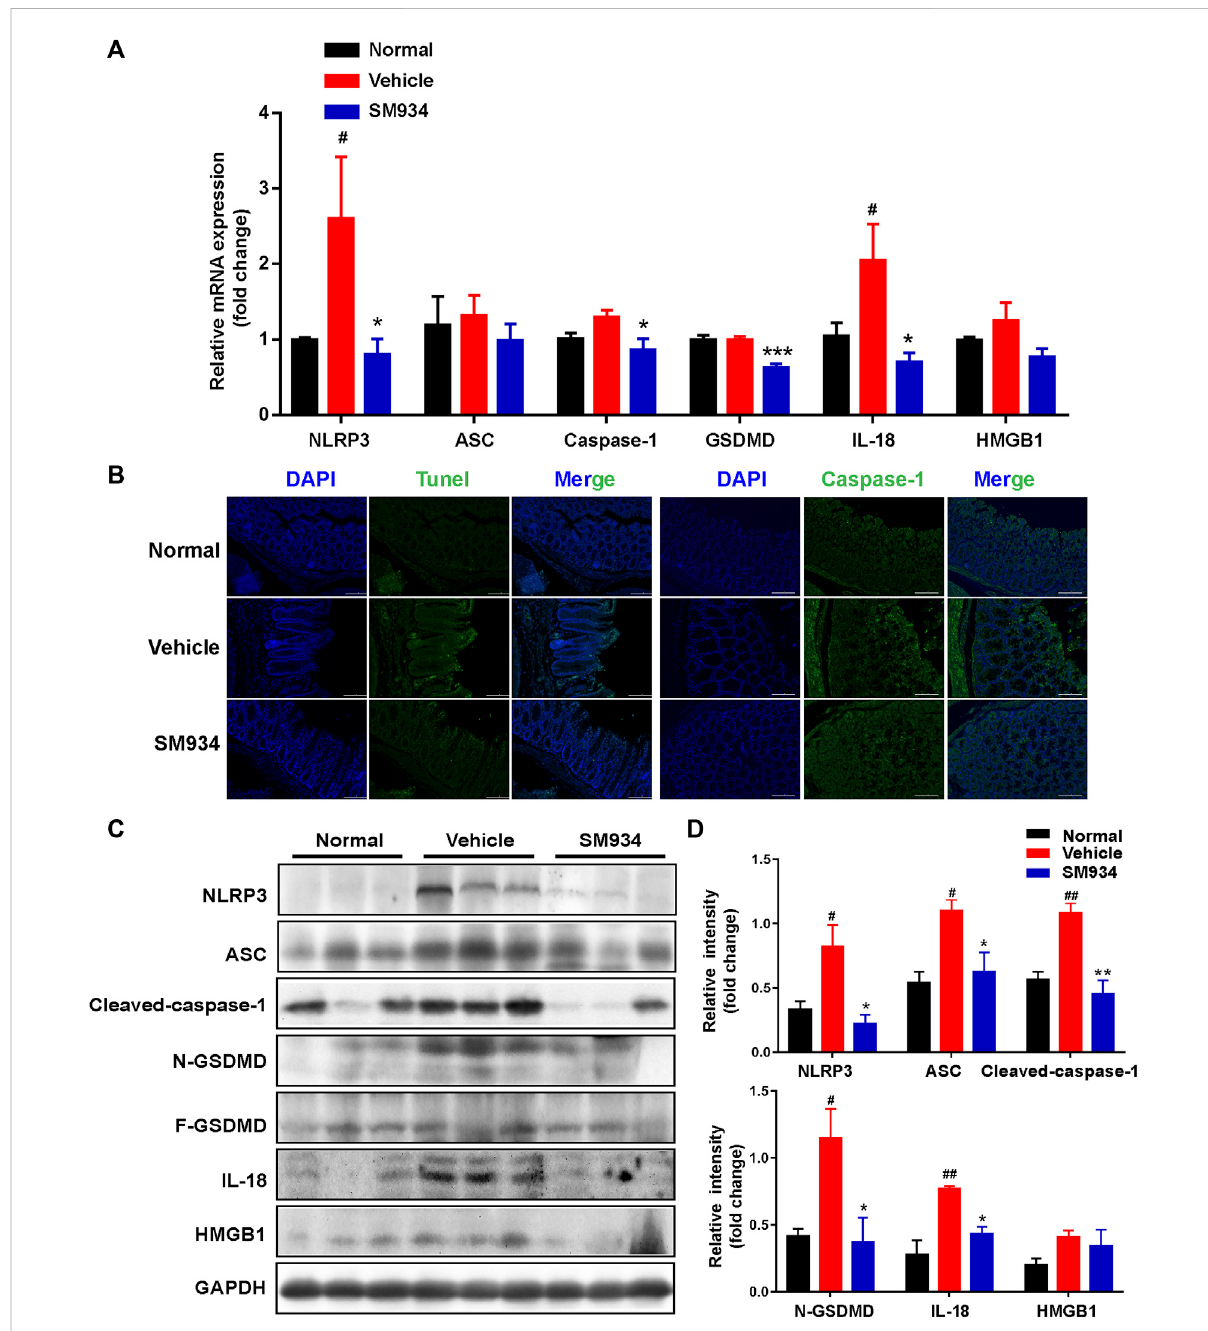
SM934 inhibited caspase-1-mediated pyroptosis activation in TNBS-induced colitis. (A) Levels of pyroptosis-related genes as determined by qPCR in colon tissues. (B) Pyroptosis hallmarkers of DNA fragmentation and caspase-1 expression were determined using the TUNEL staining assay and immuno fl uorescence staining in colon tissues, respectively (scare bar, 100 µm). (C) Expression of pyroptosis-related proteins was analyzed by Western blot assay. (D) Quantitative analysis of pyroptosis-related protein expression was conducted. Data are shown as means ± SEM ( n = 3 – 4). # p < 0.05 and ## p < 0.01 vs . normal group; * p < 0.05, ** p < 0.01, and *** p < 0.001 vs . vehicle